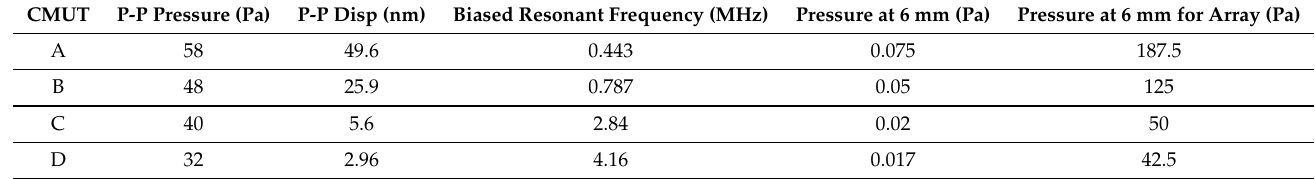
Table 4. CMUT output characteristics at 40 V DC bias.